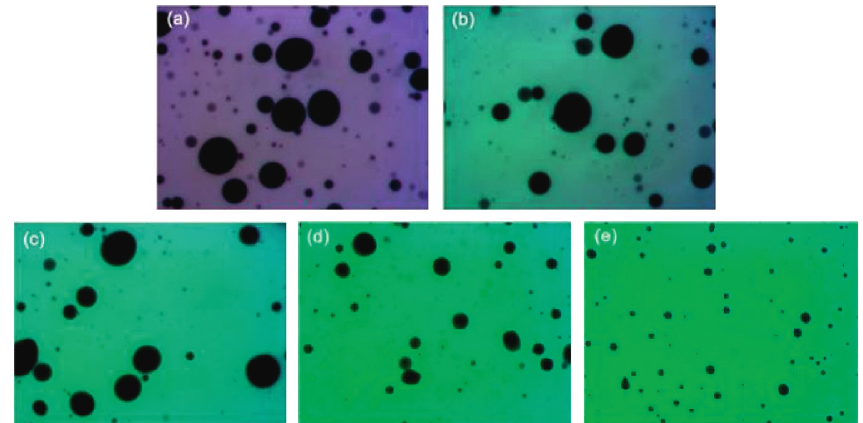
Figure 11: FM of (a) CEA blend, (b) CEA-ESO10 blend, (c) CEA-ESO20 blend, (d) CEA-ESO30 blend, and (e) CEA-ESO40 blend [71].